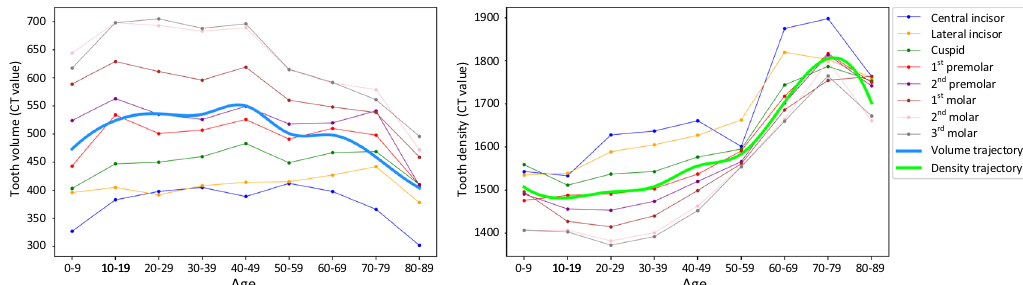
Fig. 6 The changing curves of tooth volumes and intensities over different ages